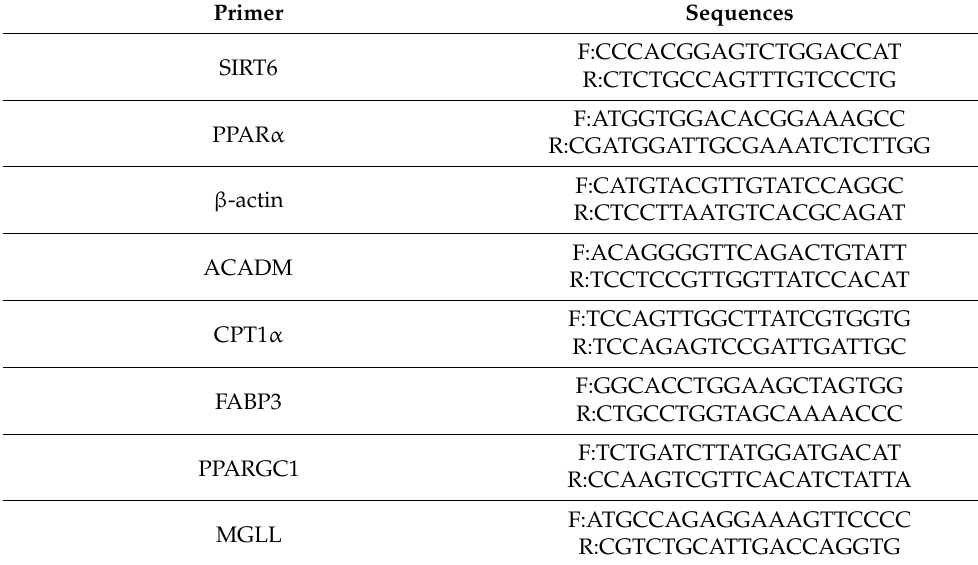
Table 1. Primers used for real-time